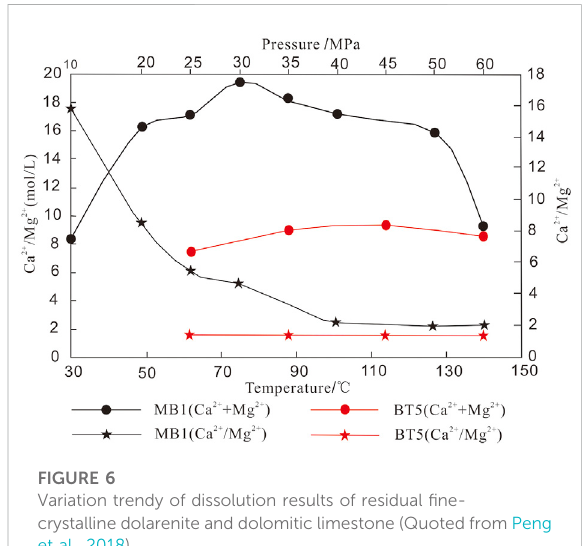
FIGURE 6 Variation trendy of dissolution results of residual fi ne- crystalline dolarenite and dolomitic limestone (Quoted from Peng et al., 2018).